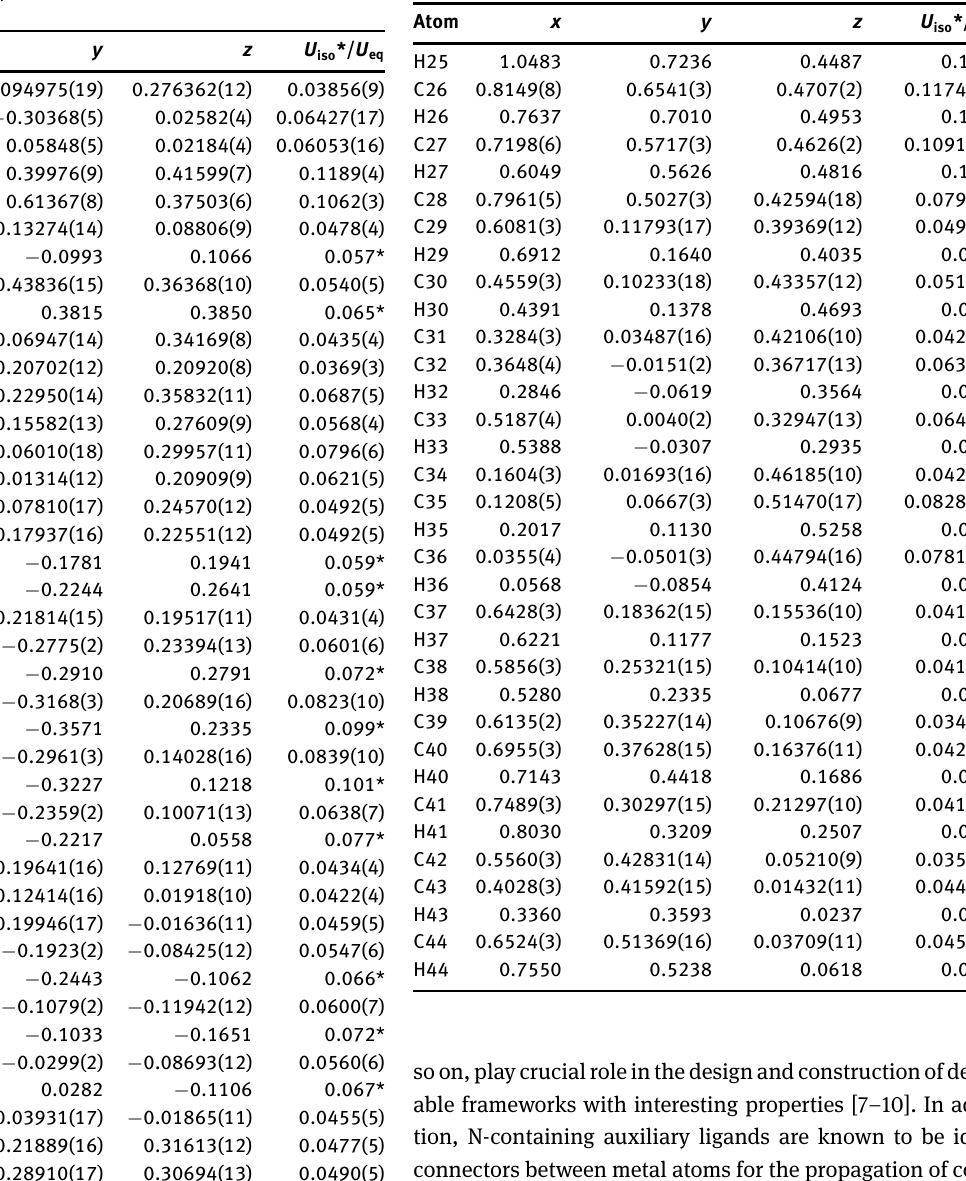
Table 2: Fractional atomic coordinates and isotropic or equivalent isotropic displacement parameters (Å 2